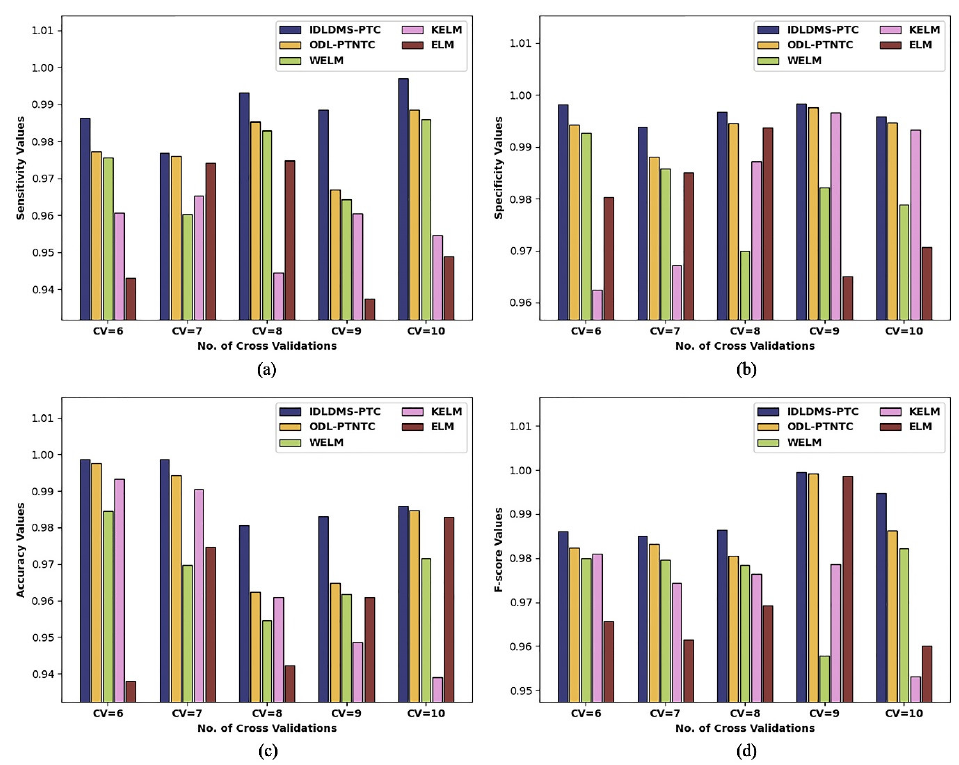
Figure 6. Result analysis of IDLDMS-PTC technique under different sizes of CV: ( a ) sensitivity, ( b ) specificity, ( c ) accuracy, and ( d ) F-score. Table 2. Result analysis of IDLDMS-PTC technique under different sizes of CV with existing ap- proaches.